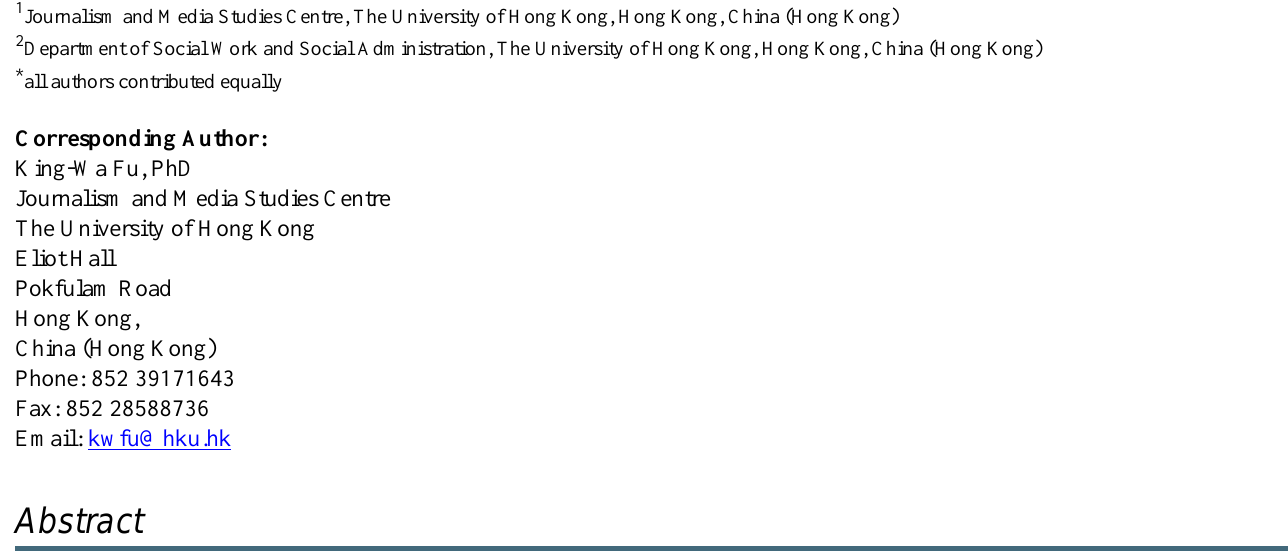
depression; help-seeking; randomized controlled